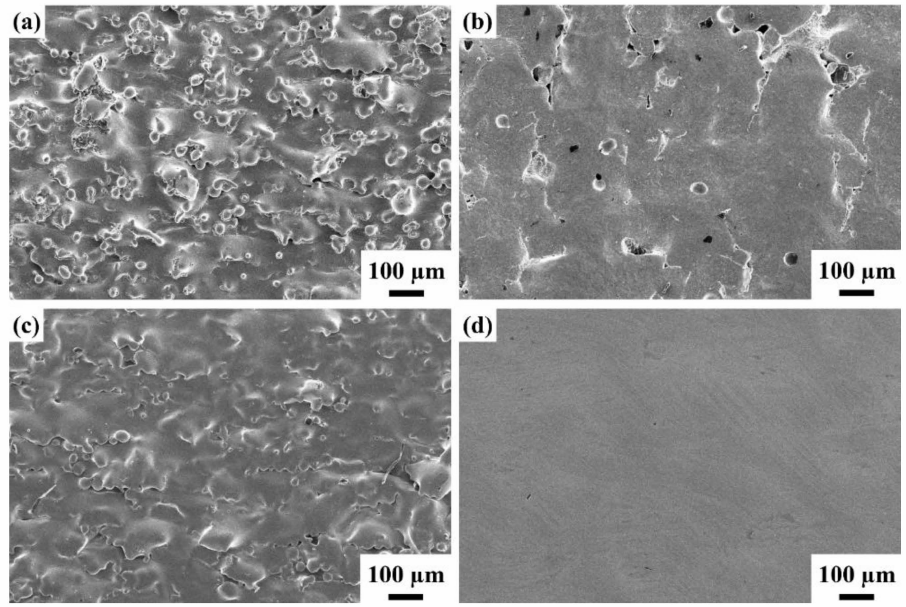
Figure 5. The SEM surface morphology for ( a ) NAPEP10, ( b ) NAPEP20, ( c ) APEP10 and ( d ) APEP20